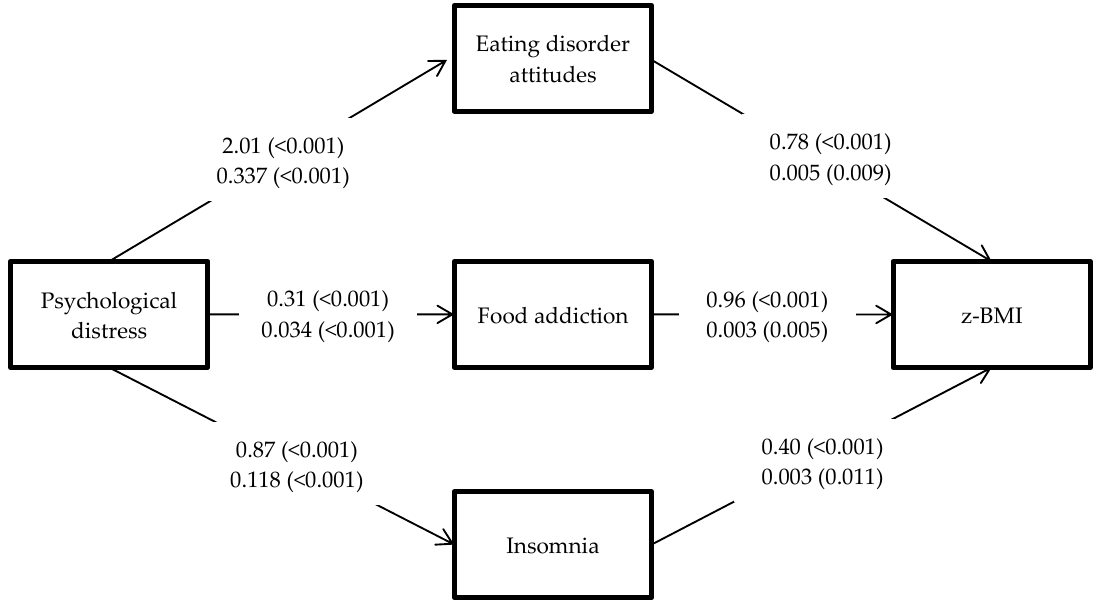
Figure 1. Mediation analysis with the hypothesized mediators of eating disorder attitudes, food addiction, and insomnia. Upper values indicate unstandardized coe ffi cients ( p -values) from Hayes’ method; lower values indicate unstandardized coe ffi cient ( p -values) from path analysis. Values from psychological distress to mediators (eating disorder attitudes, food addiction, and insomnia) are direct e ff ects from psychological distress to mediators. Values from mediators to standardized body mass index (z-BMI) are indirect e ff ects of mediators in the relationship of psychological distress and